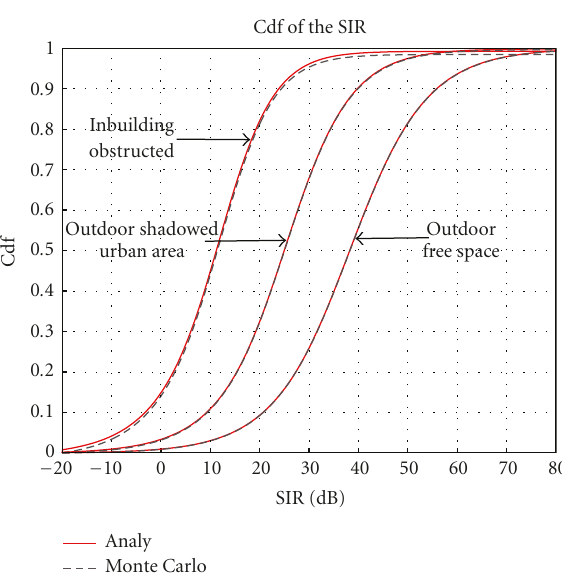
Figure 4: Plots of the pdf of the SIR for di ff erent environments